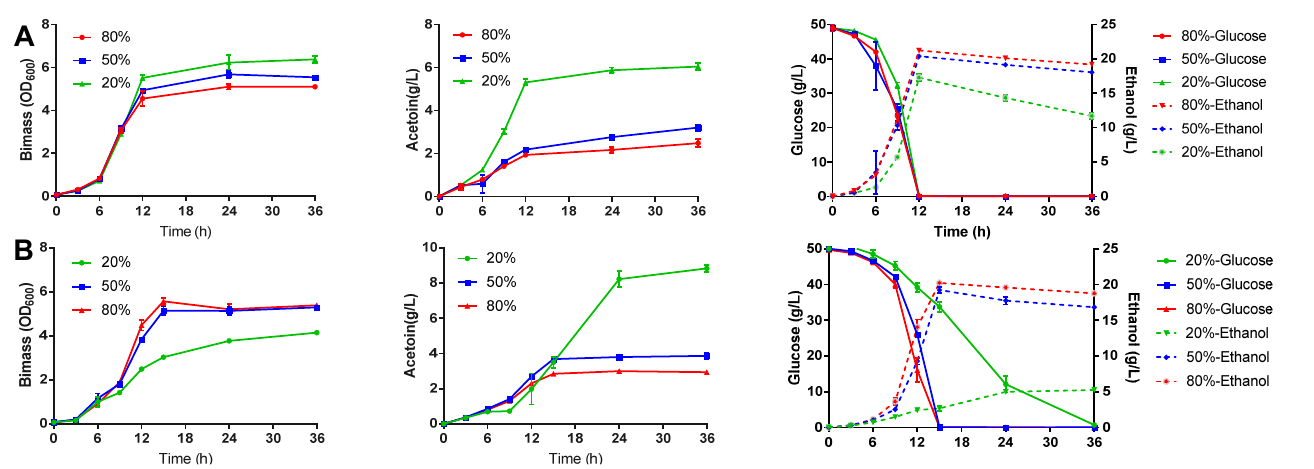
Figure 5. Growth curve and fermentation profiles of the recombinant strain ZM4 (pEZ-AldC-Als- NoxE) cultured in flasks with the shaking speed of 100 rpm (A) or 200 rpm (B). Values are the means of experiments with three or more technical replicates, and error bars are standard deviations.